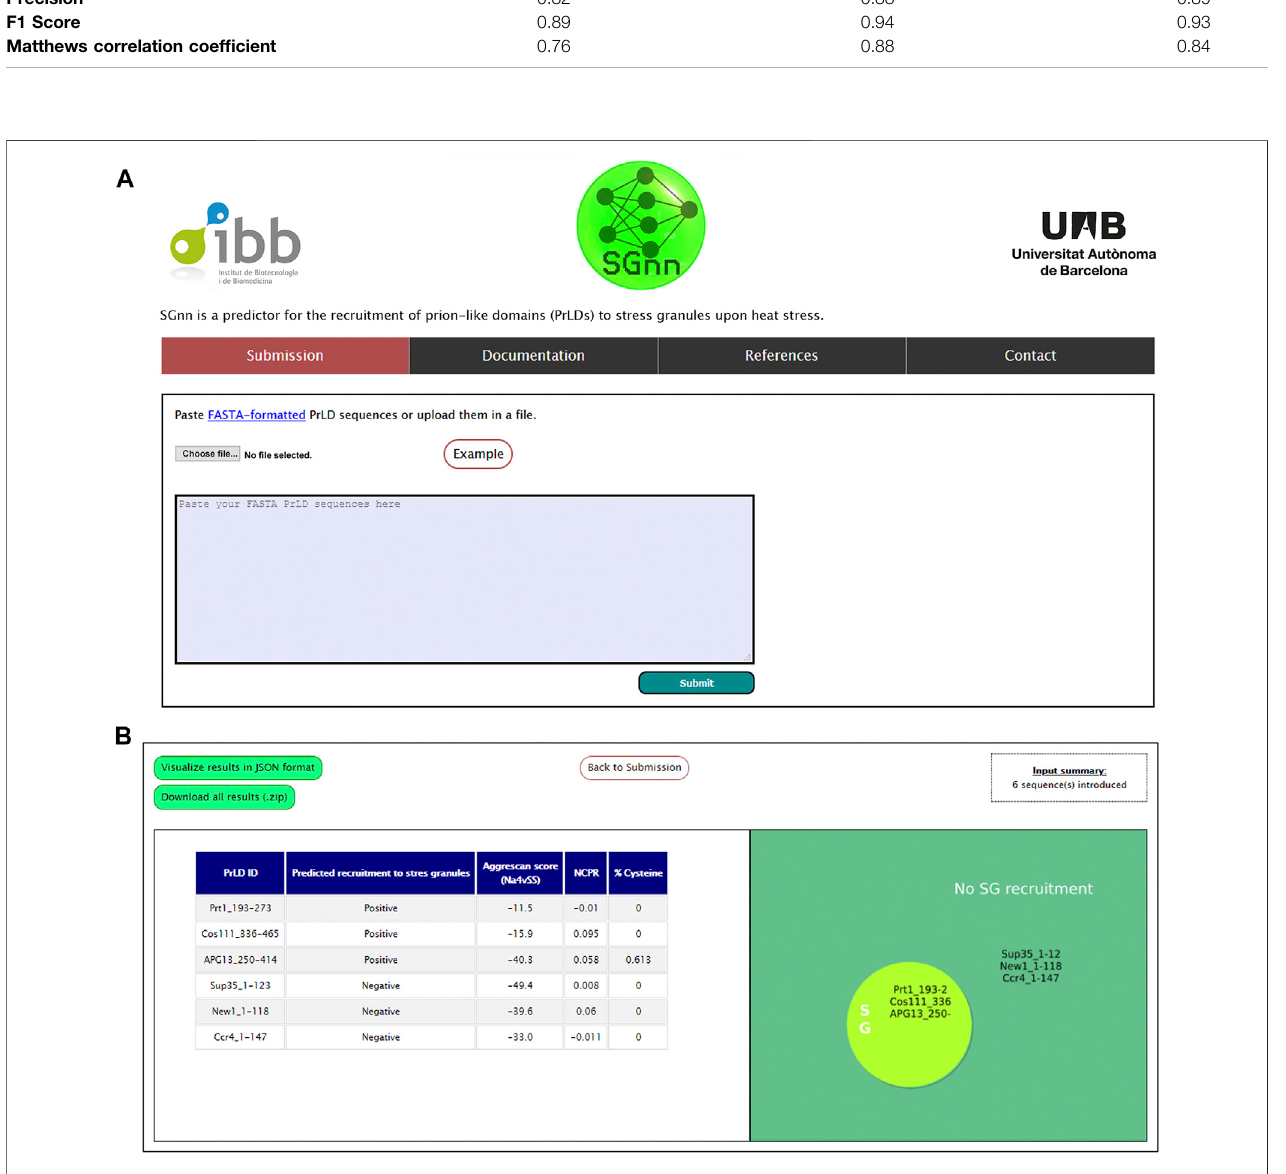
FIGURE3| SGnnwebserverinterface. (A) Webinputpage.UserscaninputtheirsequencesintheprovidedwindoworuploadtheminFASTAformat. (B) Overview ofSGnnresultspage.Oncompletion,SGnnwillshowtheresultsinatableformatanda fi guresummarizingtheprediction. Alternatively,userscanclicktheupperlinksto retrieve them in JSON or ZIP